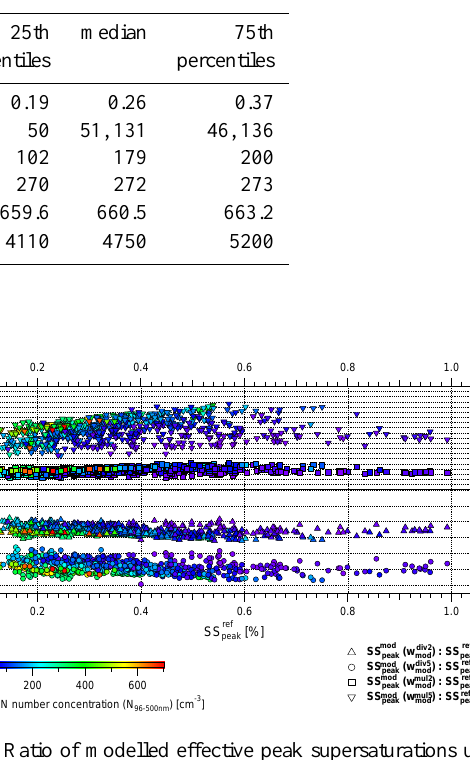
Figure 5. Ratio of modelled effective peak supersaturations using two different data sets of updraft velocities as input parameter: once divided and multiplied by 2 ( w div2 act , w mul2 act ) and once divided and multiplied by 5 ( w div5 act , w mul5 act ) to the reference updraft velocities ( w ref ). The points are colour coded to show the number concentra- tion of particles in the size range of 96nm (median dry activation diameter of CLACE2011) to 500nm (upper limit of the SMPS). This is considered to be the potential CCN number